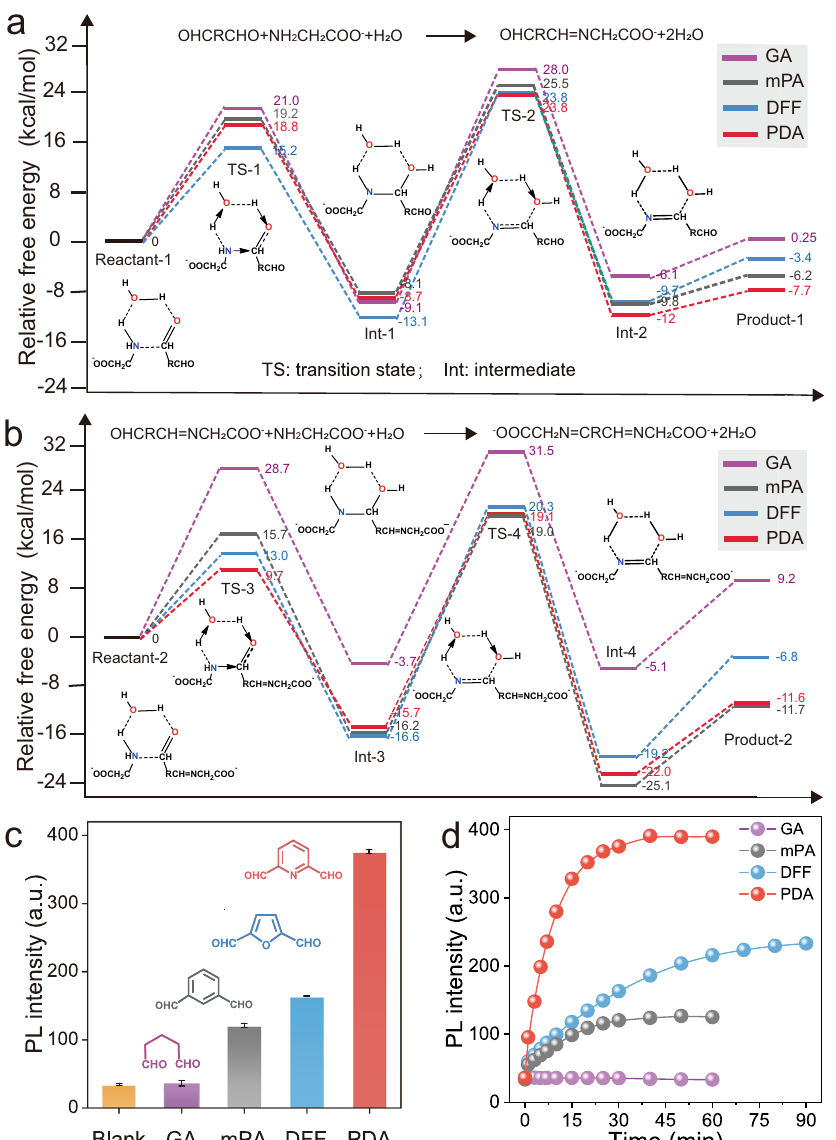
Fig. 2 Theoretical and experimental investigations of the bis-Schiff base formation reaction. a Calculated free energy pro fi les for the formation processes of mono-Schiff bases. GA glutaraldehyde, mPA m-phthalaldehyde, DFF furan-2,5-dicarbaldehyde, PDA 2,6-pyridinedicarboxaldehyde. b Calculated free energy pro fi les for the formation processes of bis-Schiff bases. Energies are calculated using B3LYP/6-311 + G(d, p) method in water. c Comparison of the luminescence intensity enhancement effects of different dialdehydes on Au 22 (SG) 18 NCs. Inset shows the chemical structures of GA, mPA, DFF, and PDA. Error bars represent standard deviation over three independent measurements. a.u. arbitrary units. d Time-dependent luminescence intensities of Au 22 (SG) 18 NCs in the presence of different dialdehydes. a.u. arbitrary